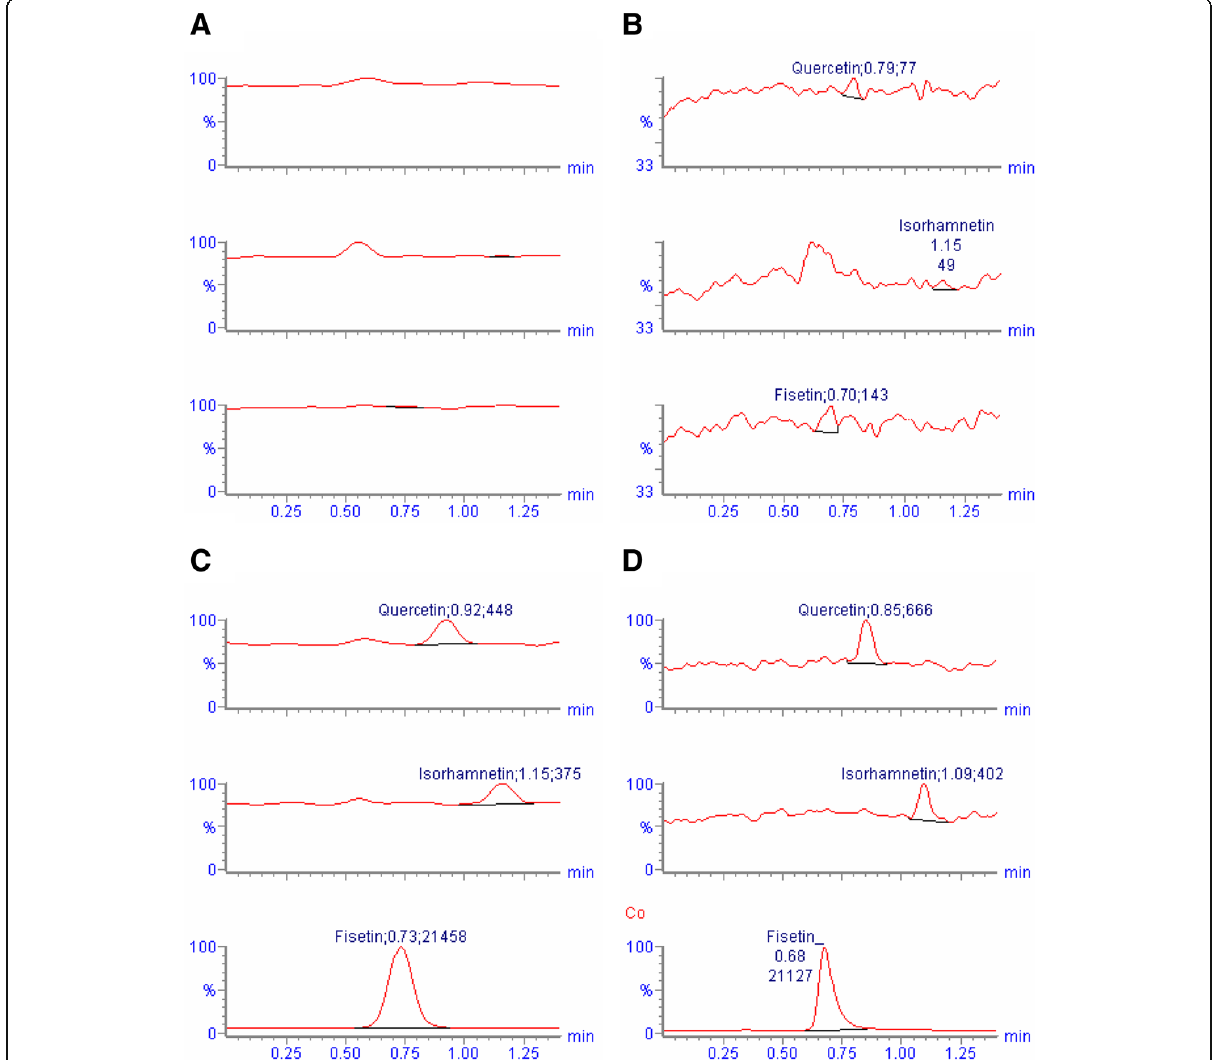
Fig. 2 Chromatograms: ( a ) blank plasma (Qu, Ir and IS free); ( c ) blank plasma spiked with 25 ng/ml Qu (LLOQ) and 25 ng/ml Ir (LLOQ); ( b ) blank urine (Qu, Ir and IS free); ( d ) blank urine spiked with 100 ng/ml Qu (LLOQ) and 100 ng/ml Ir